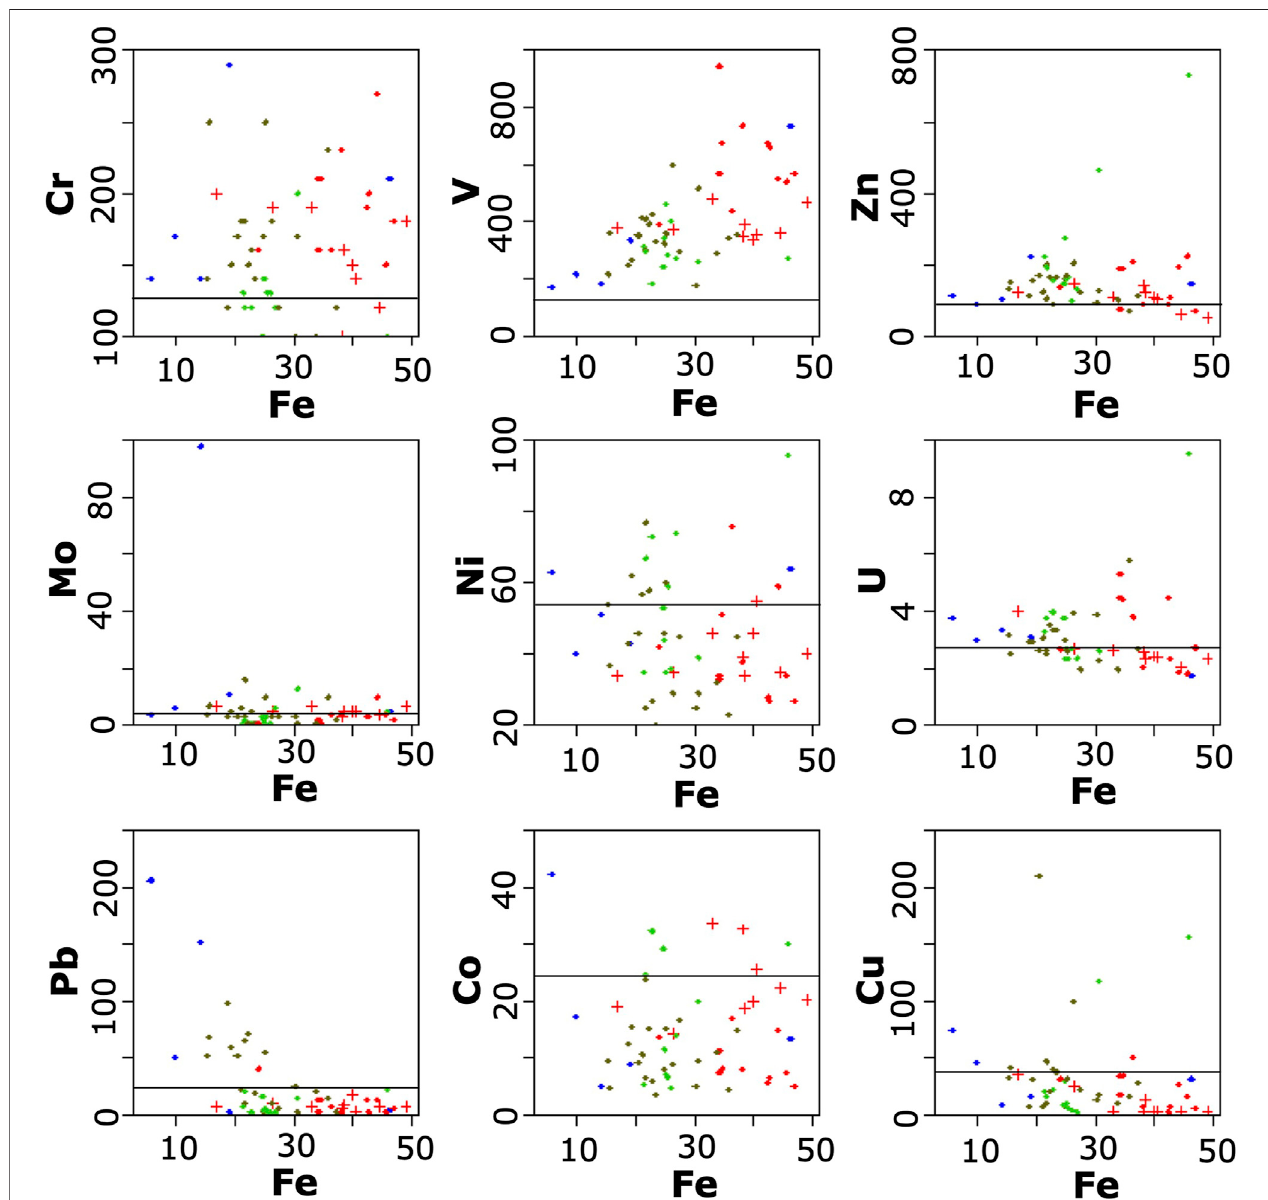
FIGURE 10 | Redox sensitive trace metals (ppm) versus Fe concentrations (%; Table 3 ). Black line denotes shale composite concentrations: Cr (cid:1) 125 ppm, V (cid:1) 130 ppm,Zn (cid:1) 100 ppm,U (cid:1) 2.7ppm,Ni (cid:1) 58 ppm,Cu (cid:1) 35 ppm,Pb (cid:1) 20ppm,Mo (cid:1) 2 ppm;Co (cid:1) 25 ppm(CompositevaluesfromMorganetal.,1978;Grometetal., 1984; Condie 1993). Colours re fl ect facies: blue (cid:1) clastic rich F1 and F3, green (cid:1) F5, brown (cid:1) F6, red (cid:1) F7, red crosses (cid:1) F7 from drill core.